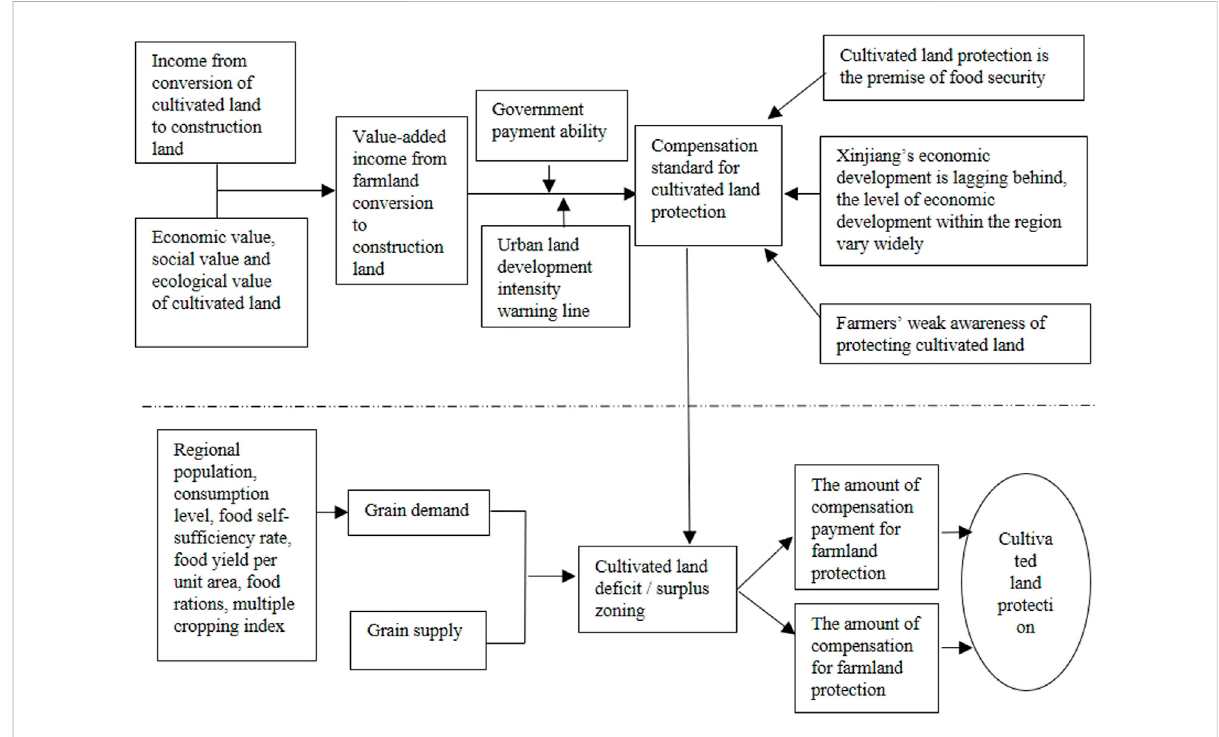
FIGURE 2 Value-added bene fi t measurement